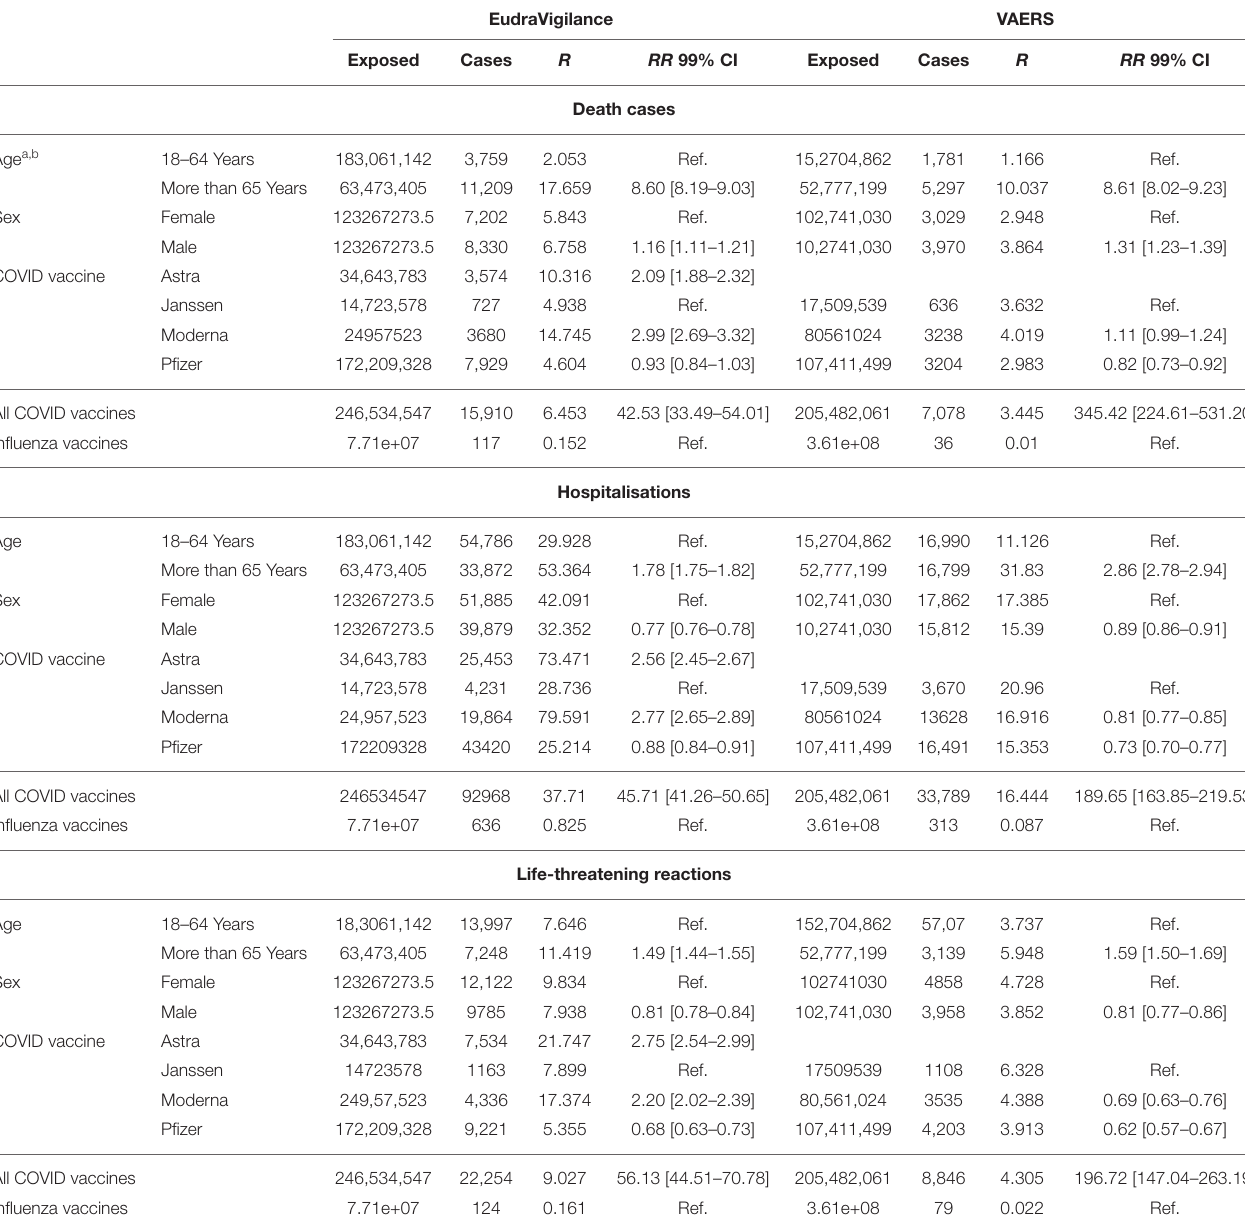
TABLE 1 | Vaccine-related risk estimates ( R ) of serious outcomes per 100,000 exposed individuals, relative risk estimates ( RR ) and 99% confidence intervals (CI) in EudraVigilance and VAERS databases. EudraVigilance VAERS Exposed Cases Exposed